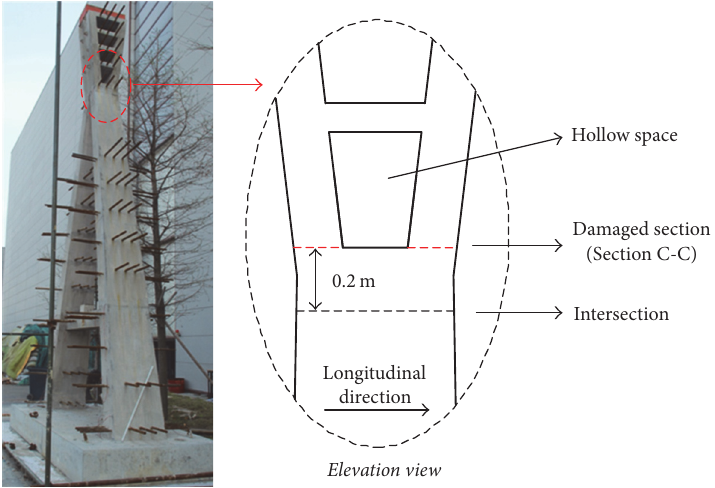
Figure 8: Configuration of Section